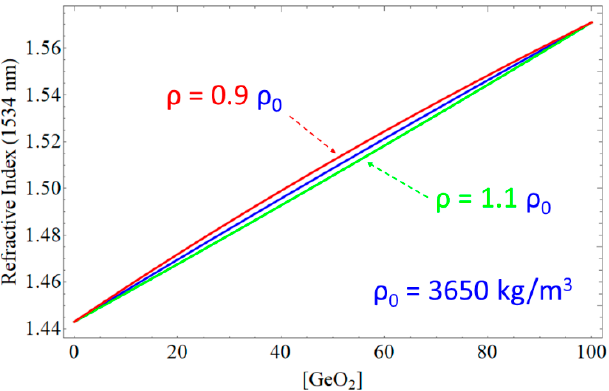
Figure 4. Simulated refractive index of binary germanosilicate as a function of the GeO 2 concentration (in mol %) for a base density of 3650 km/m 3 (blue curve). The effect of raising or lowering the density in the model affects the curvature of the functions.